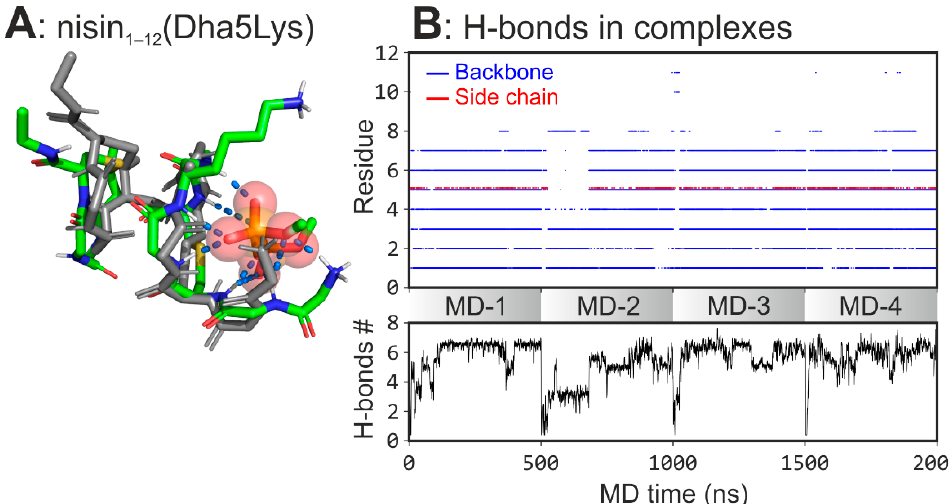
Figure 4. Spontaneous formation of nisin 1–12 (Dha5Lys)/DMPPi complexes in MD. ( A ) The representative structure of the complex. ( B ) Upper panel: hydrogen bonds map between nisin 1–12 (Dha5Lys) and DMPPi ions. Each dot indicates the H-bond between DMPPi and a particular residue backbone amide group ( blue ) or side chain ( red ) ( along the vertical axis ) at a given MD time ( along the horizontal axis ). Lower panel: the time-averaged (0.1 ns window) number of H-bonds between nisin 1–12 (Dha5Lys) and DMPPi. Both panels are stacked plots for four independent MD replicas (MD-1–4).